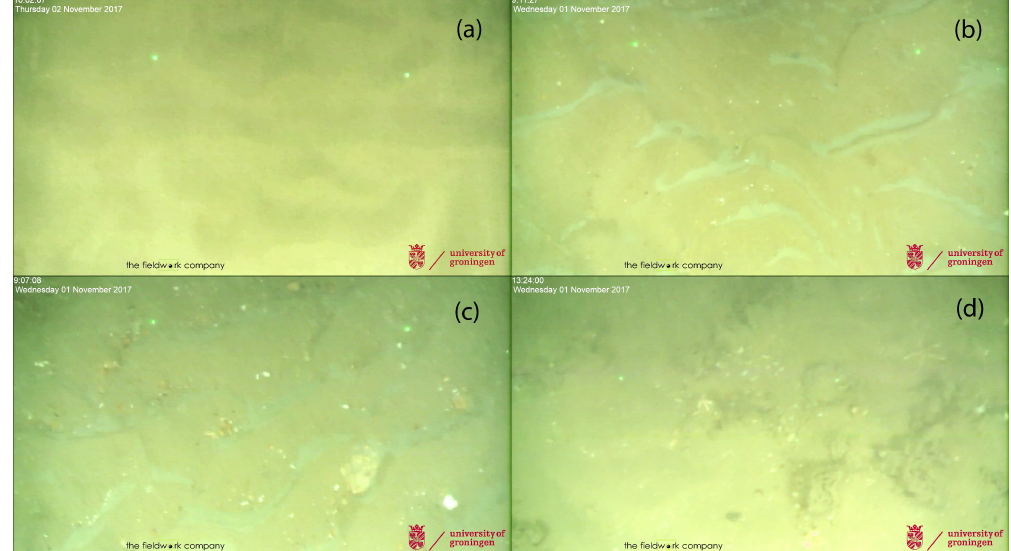
Figure 8. Sample video frames classified as ( a ) Sand with hardly any shell fragments, ( b ) Sand with some shell fragments, ( c ) Sand with small stones and incidental larger stones, and ( d ) Sand with Sabellaria fragments and incidental larger